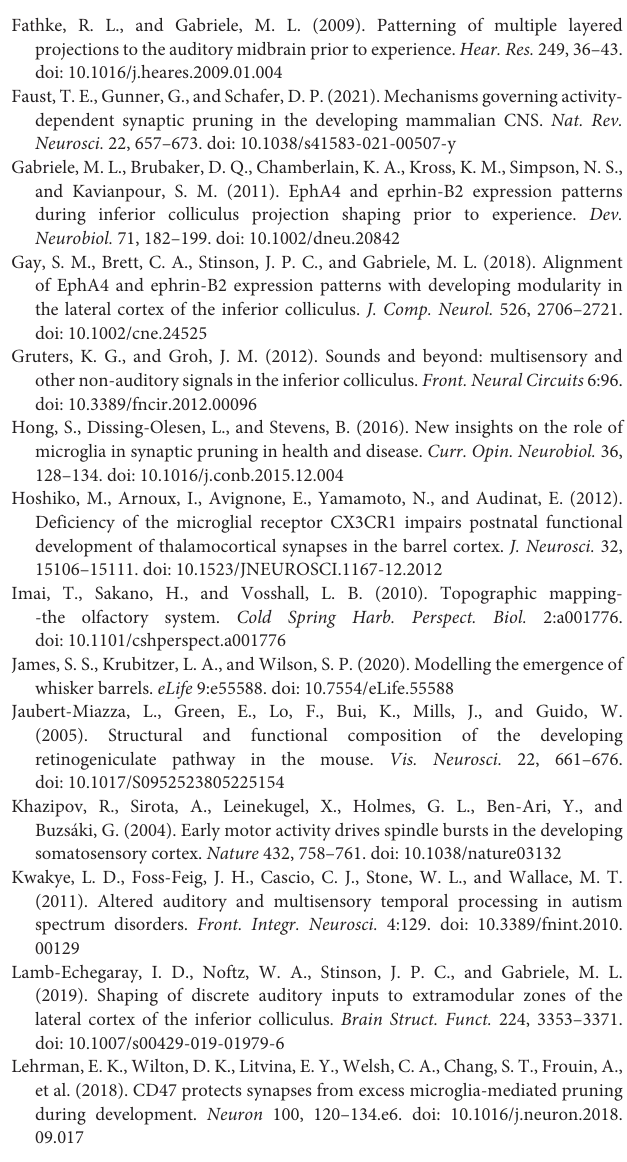
Supplementary Figure 1 | Two additional P12 cases (A–D,E–H) showing complementary, modality-specific LCIC afferent patterns. Somatosensory terminals (red) are concentrated within GAD-positive modules (green, dashed contours), while auditory inputs (cyan) distribute throughout the surrounding matrix. Projections have essentially segregated at this age (i.e. minimal overlap) with patterns in keeping with those described in the adult, suggesting the end of an early critical period for shaping discrete, multisensory LCIC input arrays. Scale bars = 100 µ